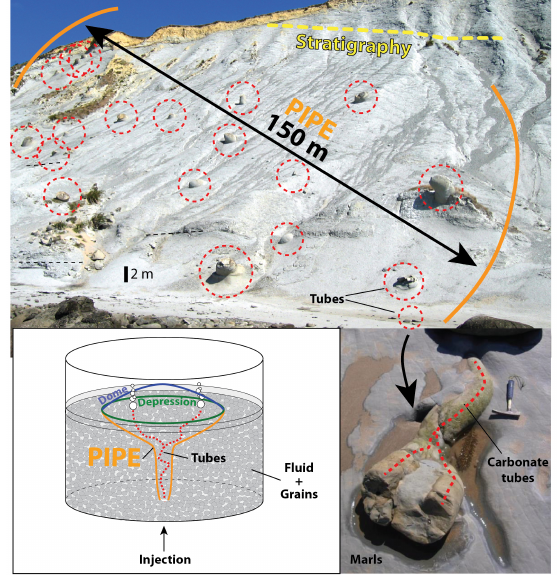
Figure 3: Example of a vast field of tubes, 150 m wide, in Cape Turnagain (New Zealand), which is now interpreted as one single conduit (i.e. a fluid